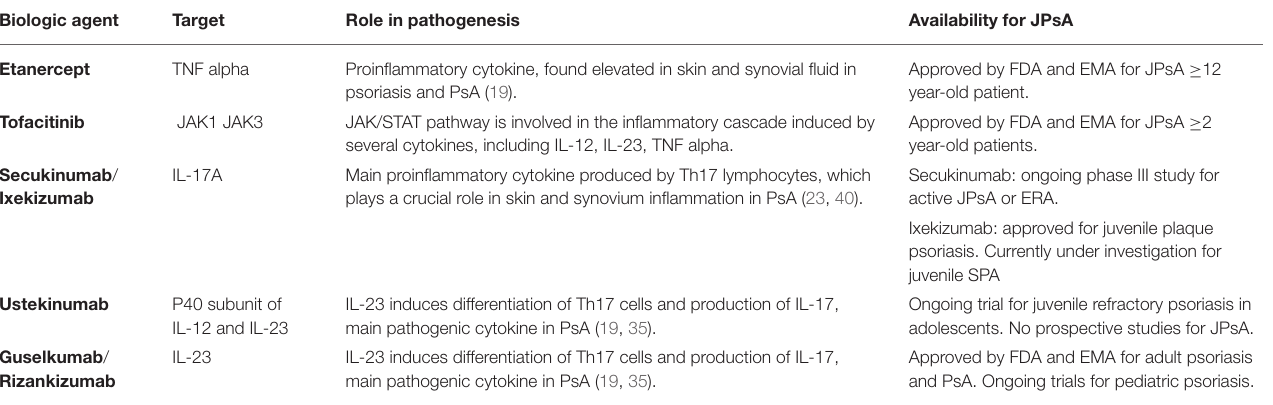
TABLE 2 | Biological agents approved or currently under study for JPI